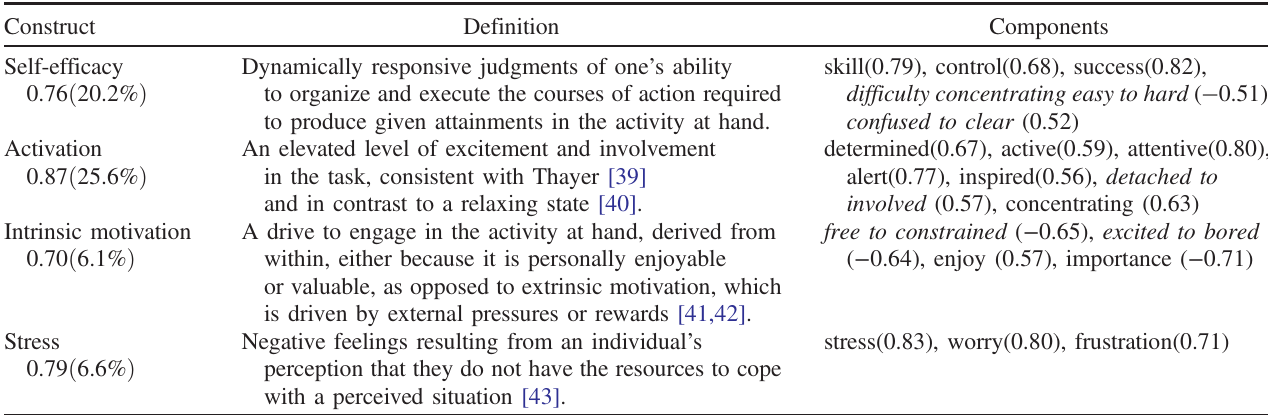
TABLE I. Affective state constructs, definitions and component questions with construct reliability measures and factor loadings. Italicized questions were asked in a 7-point bipolar format. All other questions were asked in a 5-point unipolar format. Numbers in the left hand column are: Cronbach ’ s alpha (percent variance explained). Parentheses in the right hand column are the rotated factor loading for that